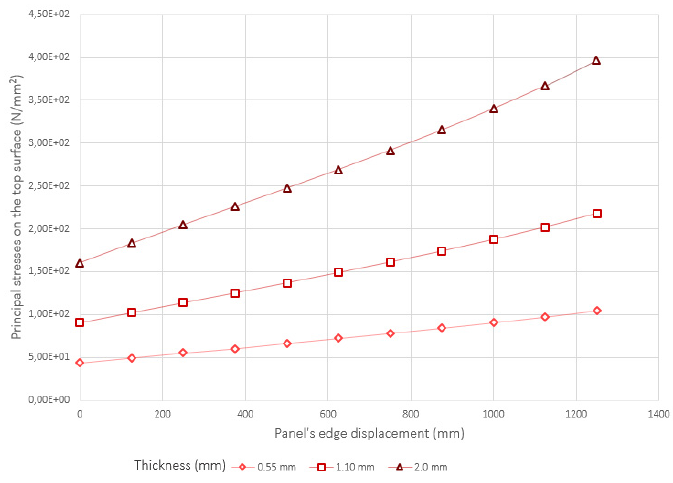
Fig. 6. Maximum bending stresses according to movement of the edge for the different